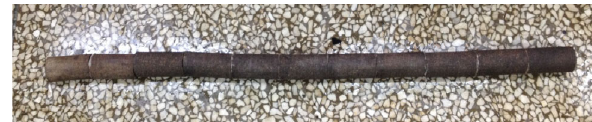
Analysis of air flooding efficiency